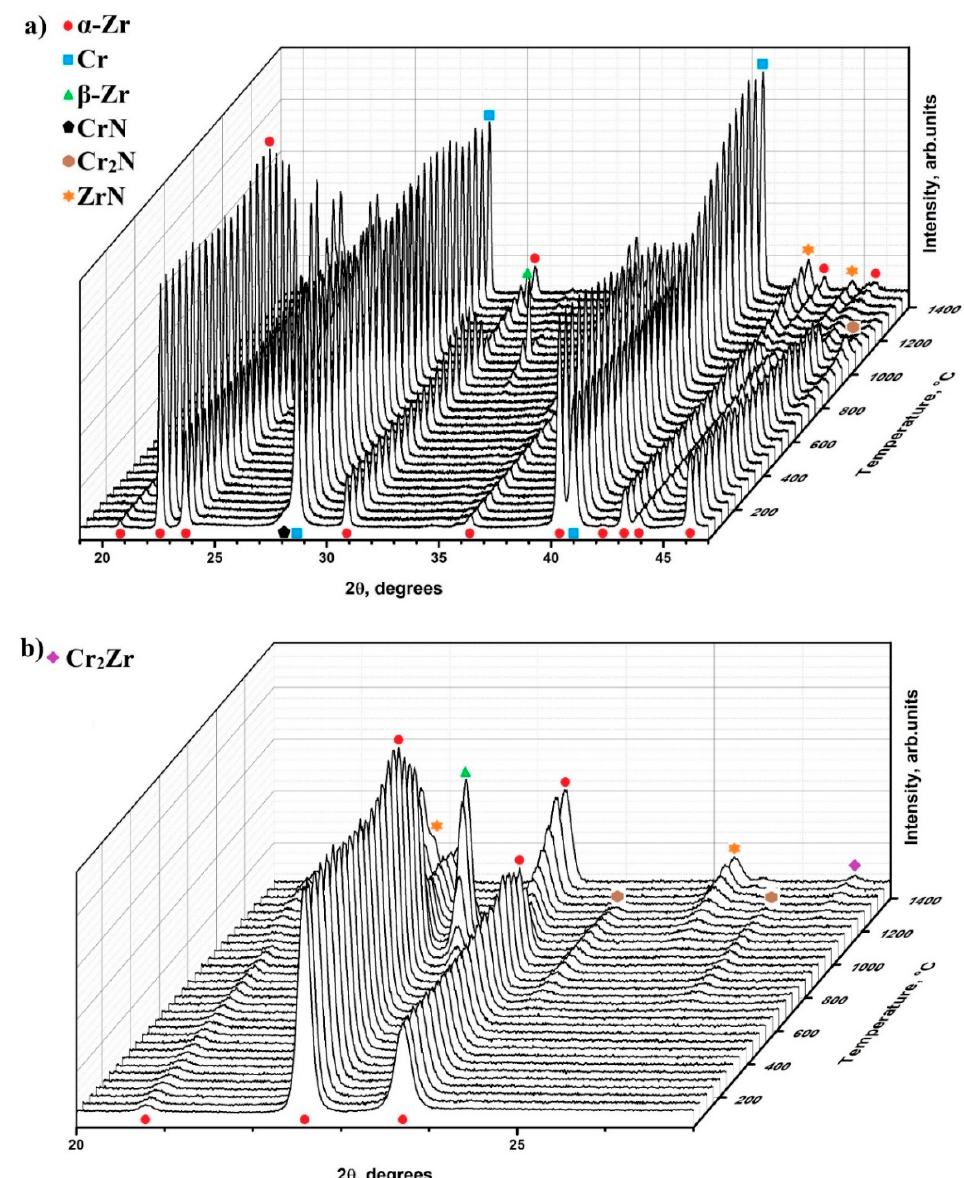
Figure 10. Phase transitions in E110 alloy with the CrN/Cr-250 coating under linear heating in the temperature range of 25–1400 °C: ( a ) 2 θ range of 19°–47°; ( b ) zoom area of 20°–27°.